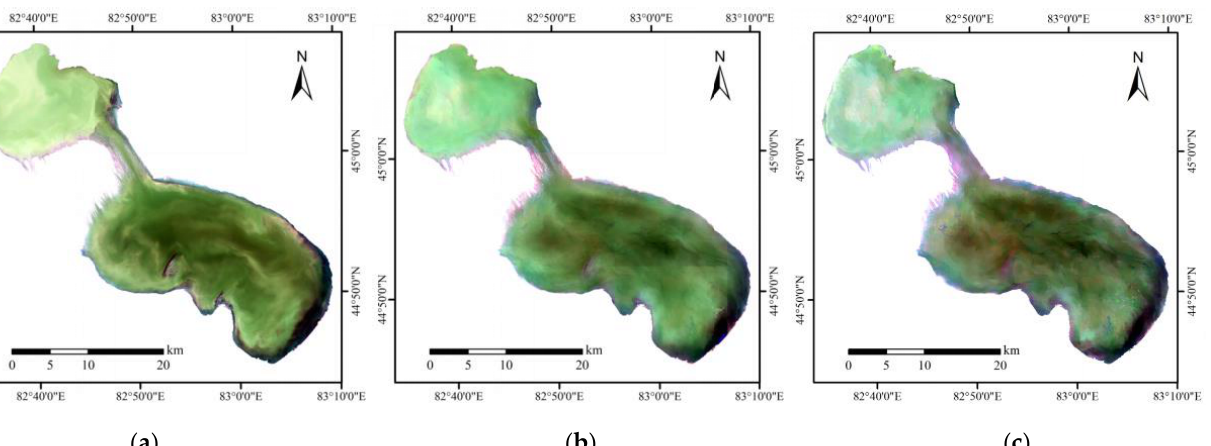
Figure 5. Scatter plots of the coefficient of determination (R 2 ) for blue, green, red, and NIR bands of the ESTARFM and FSDAF fusion images. 4.2. SPM Inversion Model 4.2.1. Screening of Sensitive Bands The absorption and scattering characteristics of light radiation by various substances in lake water determine its spectral reflection characteristics. When the SPM content in